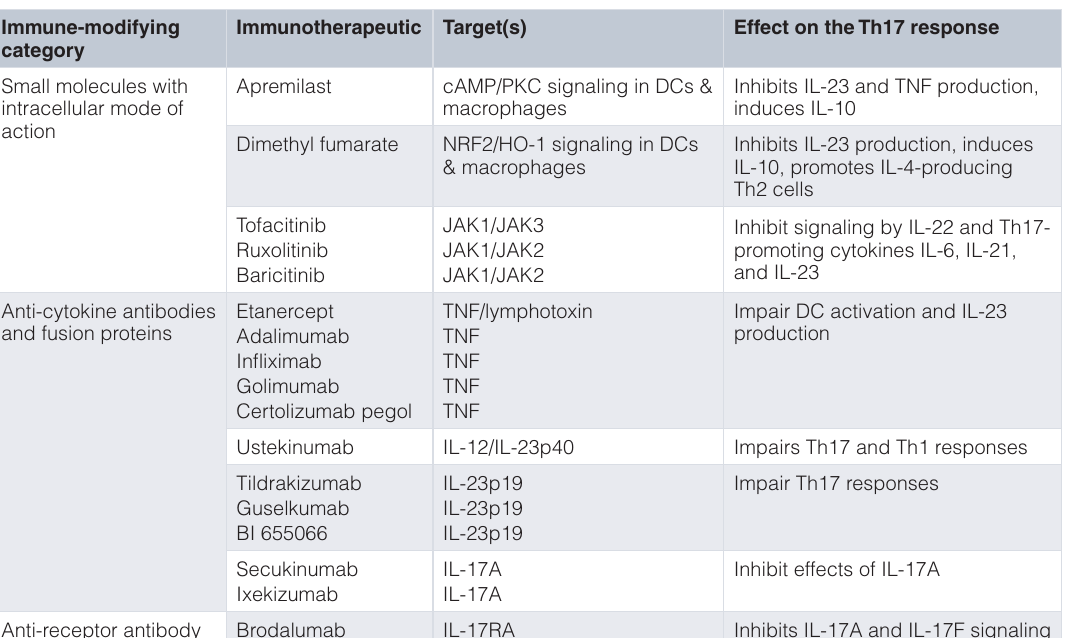
Table 1. Modern immunotherapies targeting interleukin (IL)-17/IL-23. The table summarizes approved therapeutics and compounds that are in advanced stage development (according to www.clinicaltrials.gov) and some of their effects on the Th17 response. cAMP, cyclic adenosine monophosphate; DC, dendritic cell; HO-1, heme oxygenase-1; IL, interleukin; NRF2, nuclear factor (erythroid-derived 2)-like 2; PKC, protein kinase C; Th1, T helper type 1; Th2, T helper type 2; Th17, T helper type 17; TNF, tumor necrosis